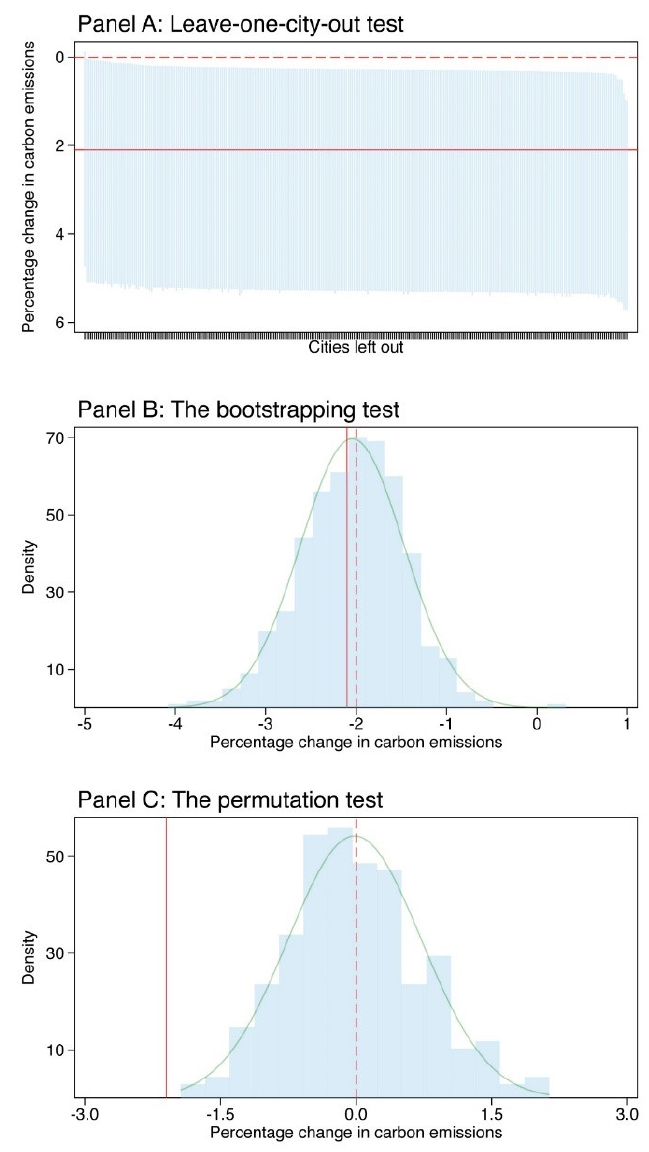
Figure 2. Robustness